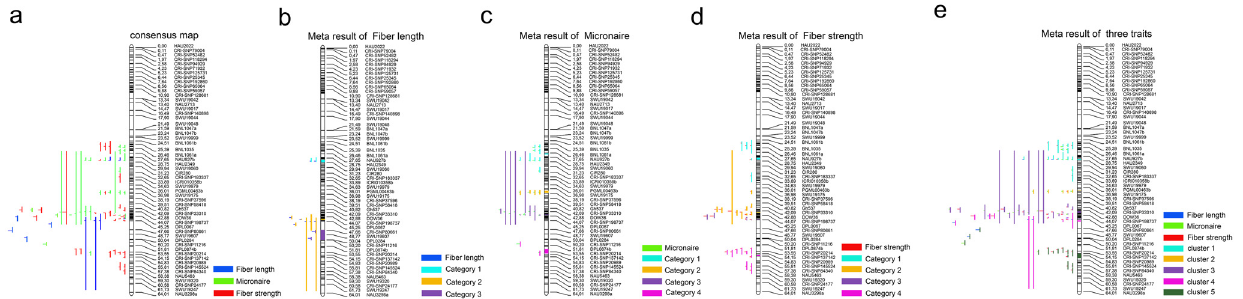
Fig 4. Meta analysis of QTLs for fiber length, fiber micronaire and fiber strength. a: concensus map; b: meta result of fiber length; c: meta result of fiber micronaire; d: meta result of fiber strength; e: meta result of all the three traits.